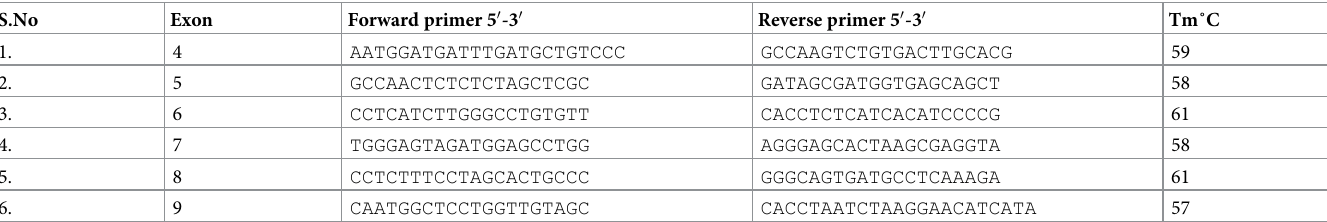
Table 1. List of primer sequence of p53 gene from exon 4–9 and their annealing temperature.